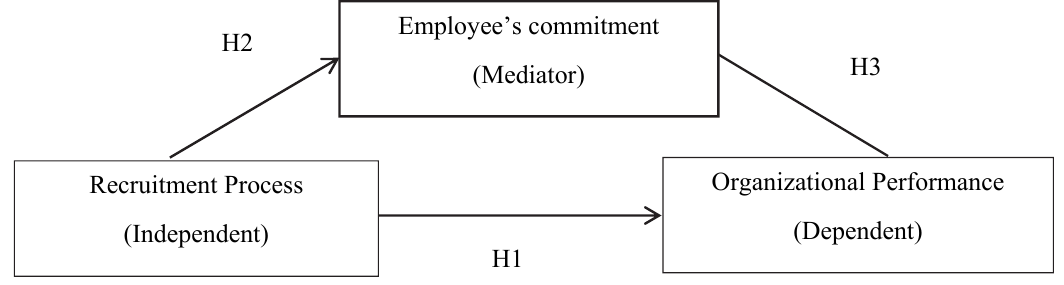
Fig. 1. The mediation model (Recruitment Process, Employee’s commitment, and Organizational Per-